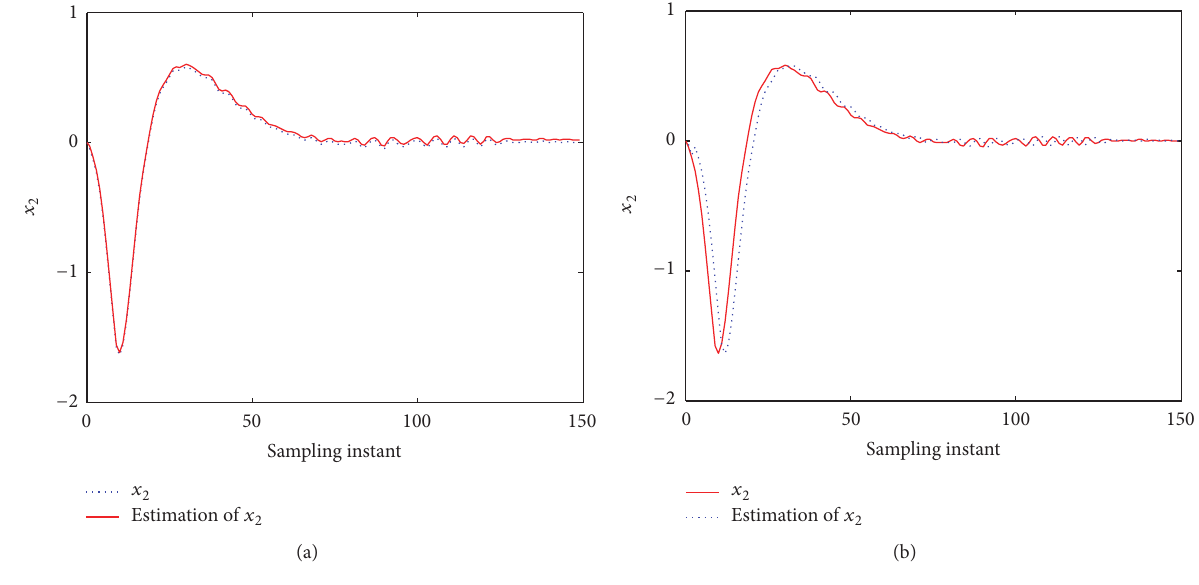
Figure 3: Comparison of 𝑥 2 and ̂𝑥 2 (a) using the NROO and (b) using the FOO.